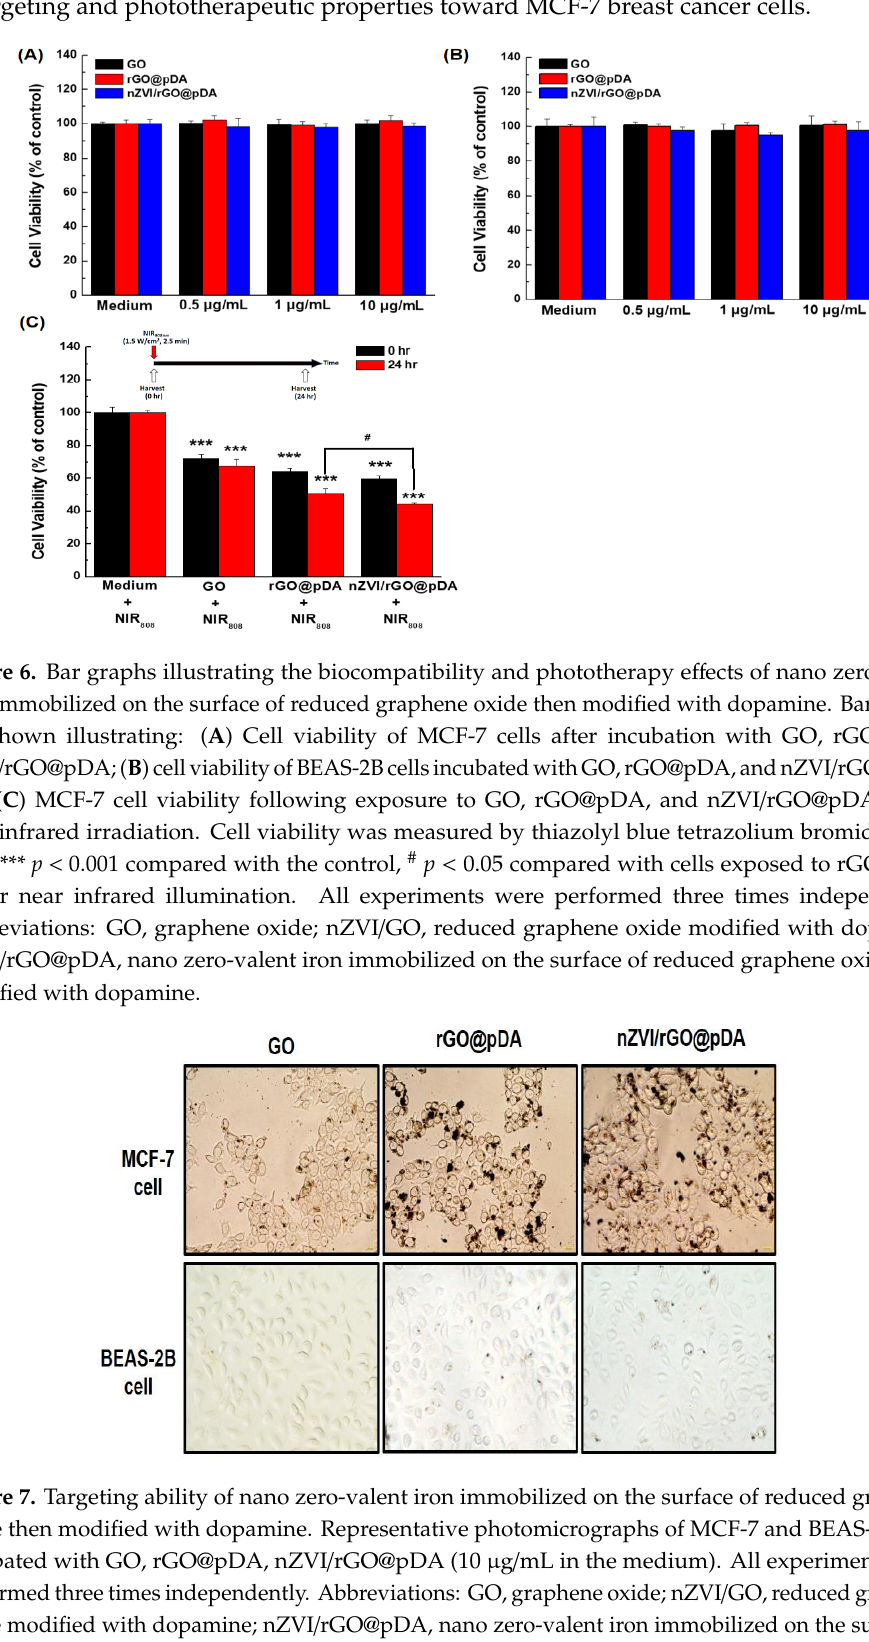
Figure 7. Targeting ability of nano zero-valent iron immobilized on the surface of reduced graphene oxide then modified with dopamine. Representative photomicrographs of MCF-7 and BEAS-2B cells incubated with GO, rGO@pDA, nZVI / rGO@pDA (10 µ g / mL in the medium). All experiments were performed three times independently. Abbreviations: GO, graphene oxide; nZVI / GO, reduced graphene oxide modified with dopamine; nZVI / rGO@pDA, nano zero-valent iron immobilized on the surface of reduced graphene oxide then modified with